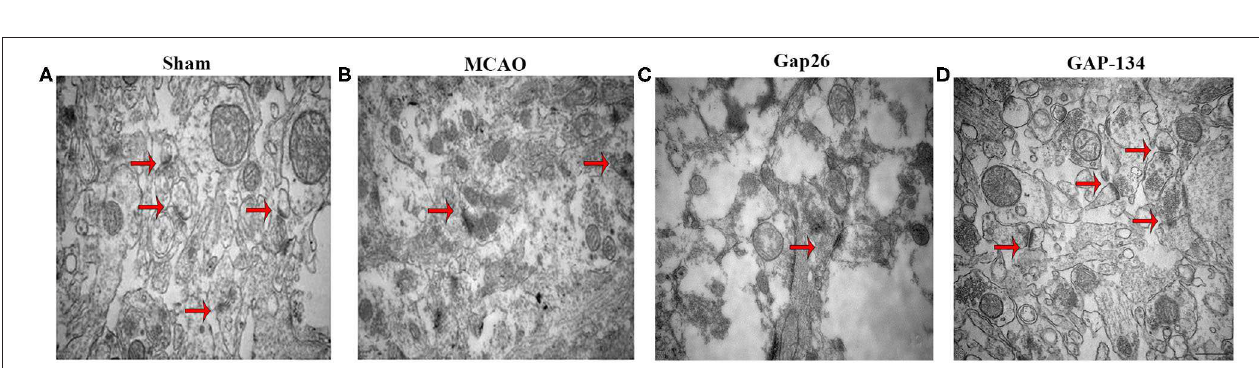
FIGURE 4 | Effects of Gap26 and GAP-134 on ultrastructural changes in the hippocampus at 7 d after MCAO. Representative synapse ultrastructure of all groups. The structure of synapses was intact and clear in the sham group (A) ; however, destructed synapses were seen after MCAO (B) , demonstrated by dim cleft, fusion of synaptic space, and etc. Gap26 further deteriorated it (C) while GAP-134 improved it (D) . Synapses were indicated in red arrows. Scale bar =